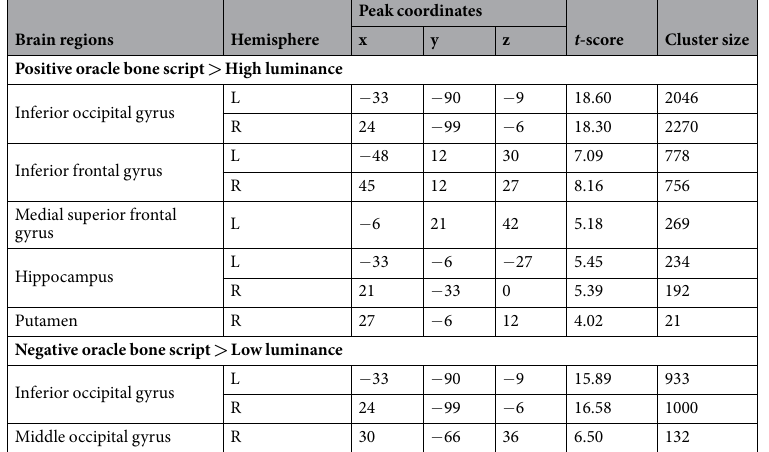
Table 2. Activated areas correlating with the aesthetic judgments of oracle bone scripts. Note: Coordinates refer to the stereotactic space of the Montreal Neurological Institute. The statistical significance refers to p < 0.001 at